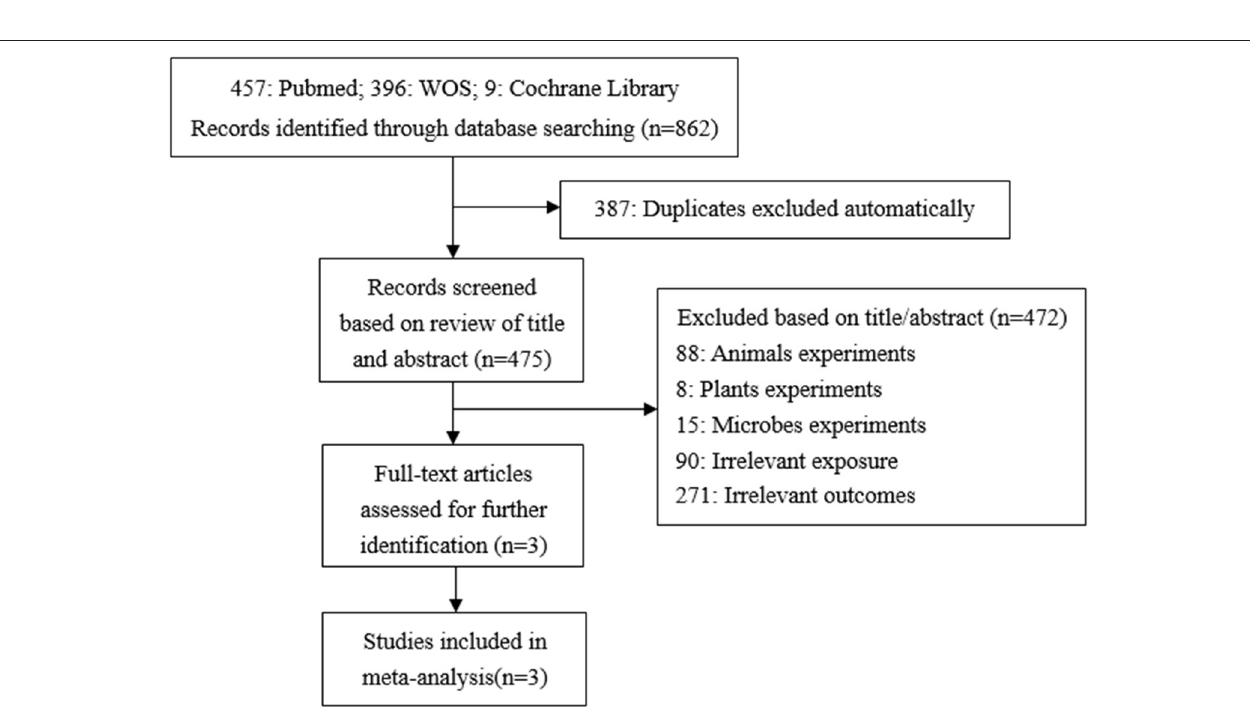
FIGURE 2 | Flow chart of the association between urinary TCS level in children and children’s BMI.